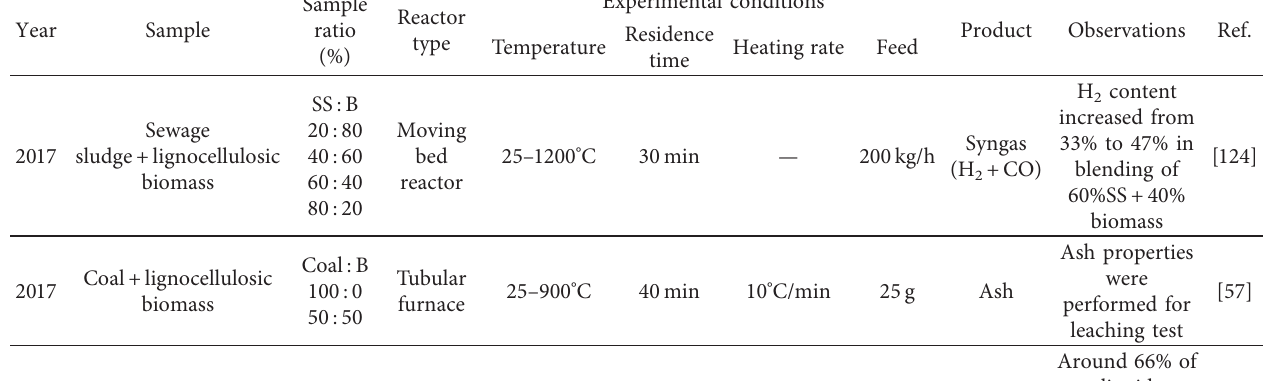
Table 5: Thermal coconversion of different samples by using copyrolysis and cocombustion